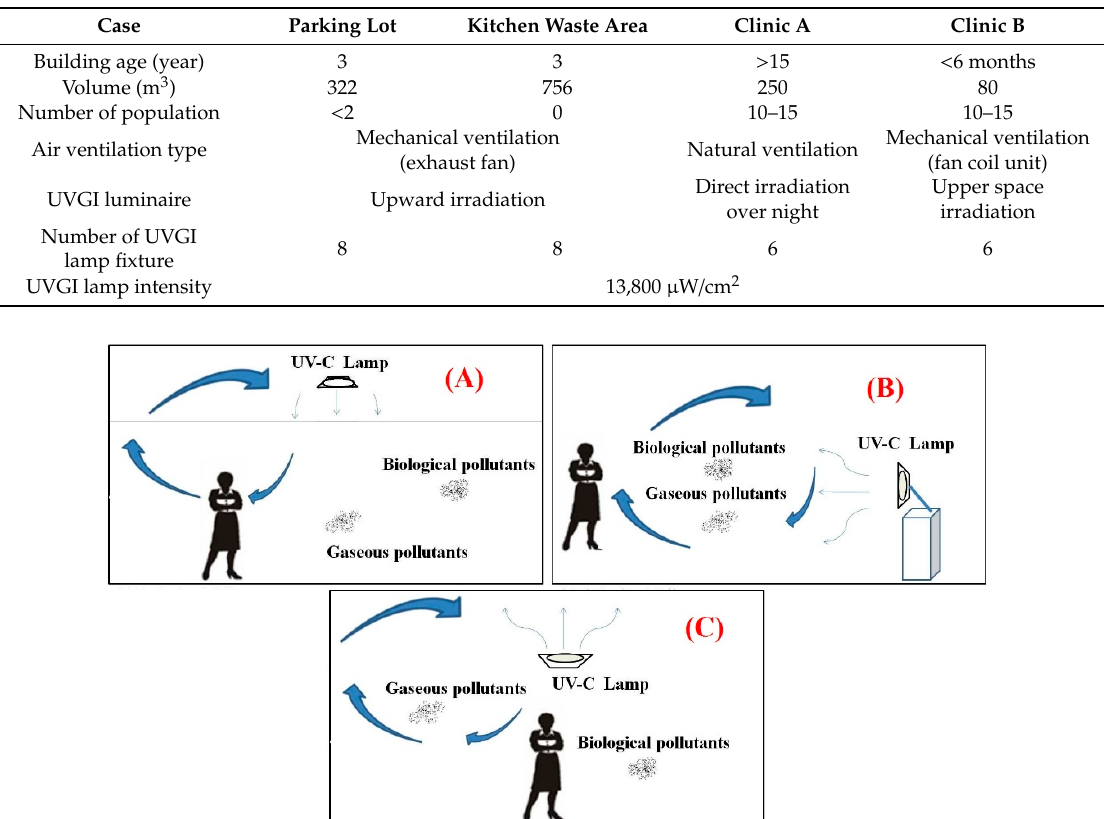
Figure 2. The configuration of three types of UVGI luminaire in field tests: ( A ) Upper space irradiation, ( B ) direct irradiation overnight, and ( C ) upward irradiation.